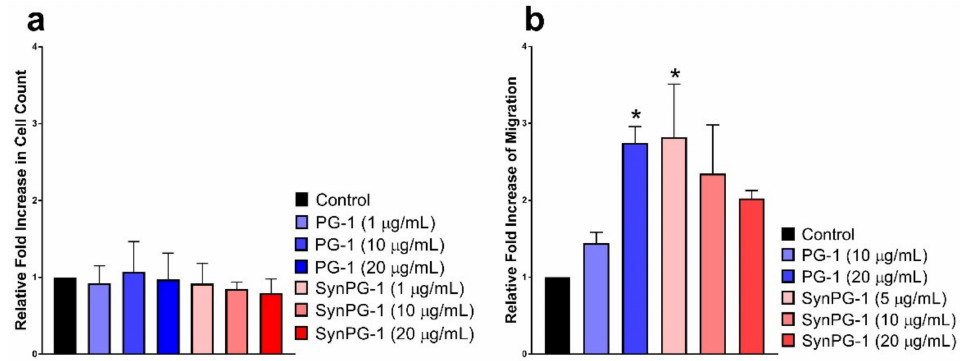
Figure 9. Comparing the e ff ects of peptide treatment on stimulating ( a ) cell proliferation in IPEC-J2 cells after 24 h incubation in peptide treatment, represented by the relative fold increase in cell count, and ( b ) cell migration of IPEC-J2 after 16 h incubation is represented as the % cell viability of cells in 2% serum after a 3 h incubation with peptide, relative to cells without peptide treatment. Data represents the mean ± SEM of three independent experiments, where n = 4. The asterisks represent a significant di ff erence at p < 0.05, as compared to the control by one-way ANOVA with a post hoc Dunnett test. Meanwhile, the e ff ect of the PG-1 and the hybrid peptide in stimulating cell migration was accessed through a transwell assay. As shown in Figure 9b, starting at 20 µ g / mL, PG-1 increased cell migration significantly. The migration-inducing e ff ect by SynPG-1 was observed at 5 µ g /